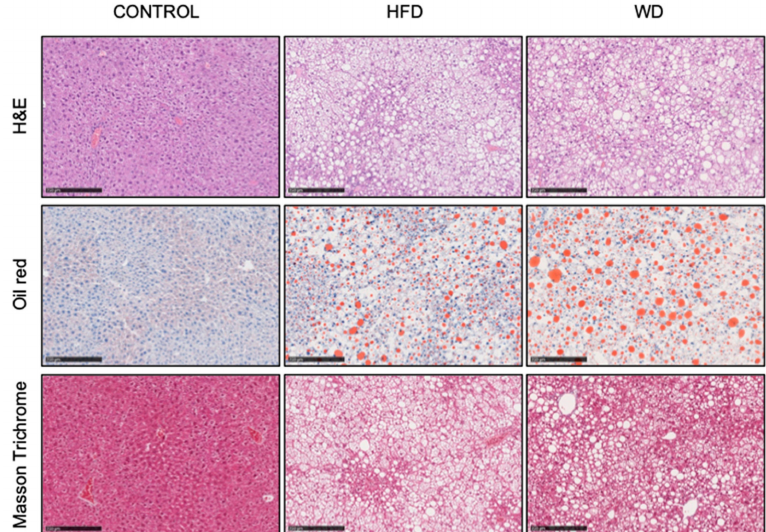
Figure 1. Histological staining of livers from mice fed with standard chow (C), high-fat diet (HFD), and Western (WD) diet at 16 weeks. Haematoxylin and eosin (H&E), Oil Red and Masson Trichrome staining shown in the upper and the lower panels, respectively. Scale bars, 250 µ m; magnification is 10 ×